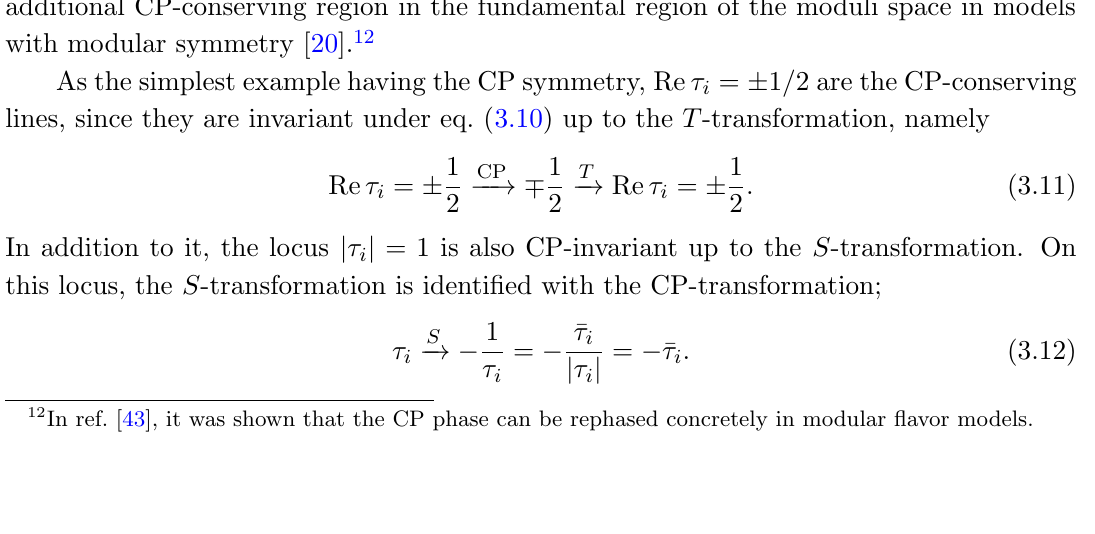
three-form of 6D space. Given the holomorphic three-form (cid:10) = dz local coordinates of the 6D space f z corresponds